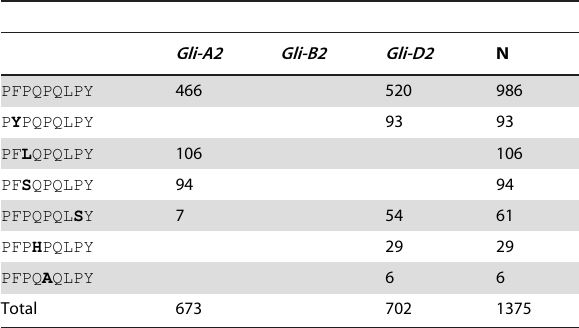
Table 2. HLA-DQ2-Glia- a 1 epitope variants expressed in bread